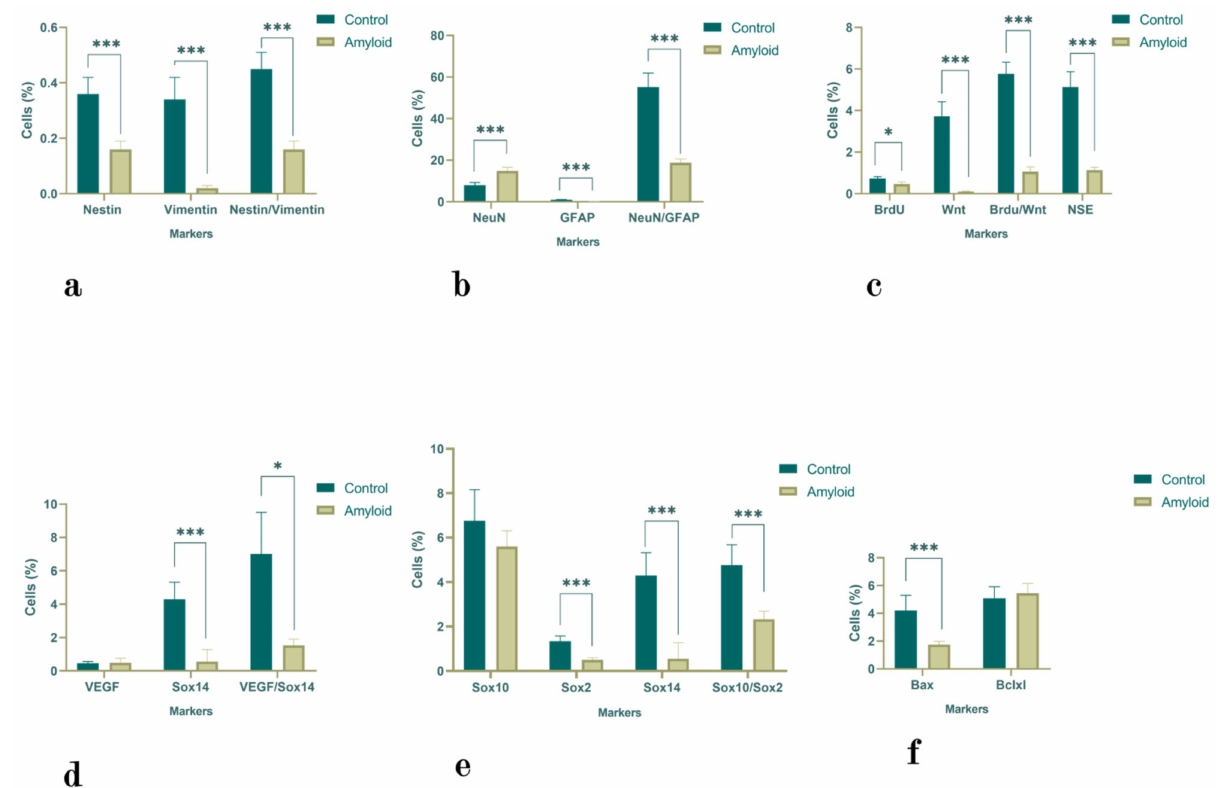
Figure 3. The proportion of Nestin-, Vimentin-, and Nestin/Vimentin- ( a ); NeuN-, GFAP-, and NeuN/GFAP- ( b ); NSE-, BrdU-, Wnt-, and BrdU/Wnt- ( c ); VEGF-, Sox14-, and VEGF/Sox14- ( d ); Sox10-, Sox2-, Sox14-, and Sox10/Sox2- ( e ); and Bax-and Bcl-xL-positive cells ( f ) in the olfactory bulb under normal conditions and with A β (1-42). Statistical significance is indicated as follows: *** p < 0.0001 and * p <